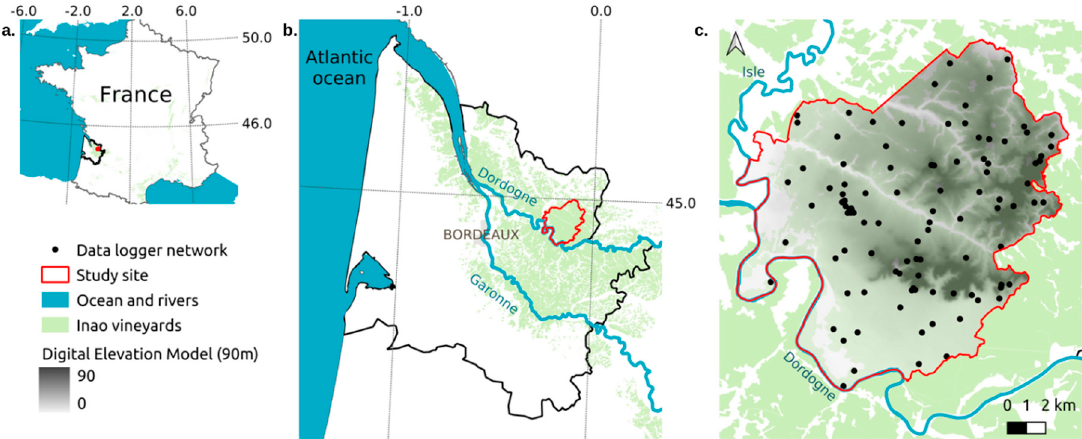
Figure 1. ( a , b ) The Saint ‐ Emilion and Pomerol study site (red border) and the administrative department of Gironde (black border) in southwestern France, and ( c ) the study site’s topography and network of 90 air temperature data loggers (black points).